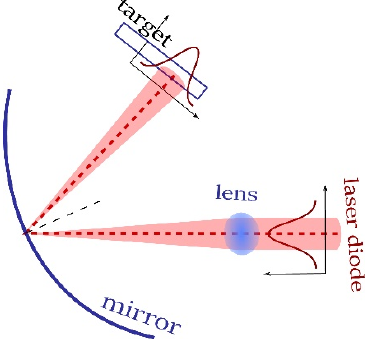
Figure 9. Scheme for the reflection of the laser beam with converging lens. The dotted red line indicates the path of the central ray.